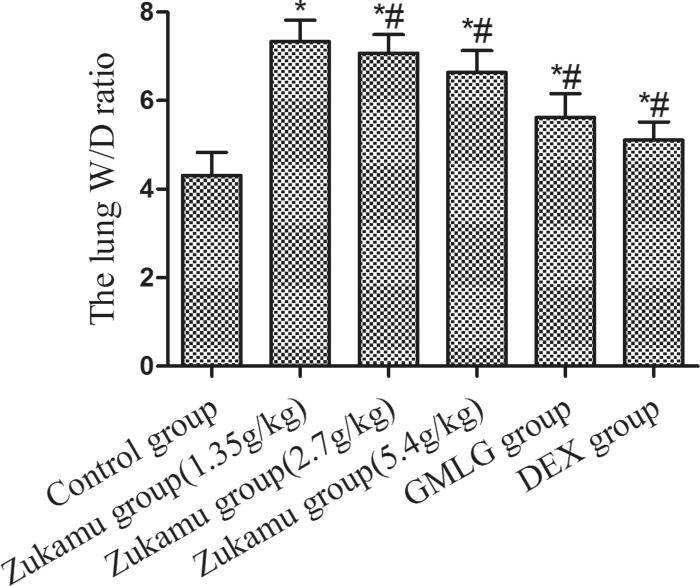
Zukamu decreased the lung W/D ratio of rats with acute lung injury. Sprague–Dawley rats were treated with different doses of zukamu (1.35, 2.7 and 5.4 g/kg) (ig.) and positive anti-inflammatory control drug DEX (ip.) Acute lung injury was induced by LPS injection 60 min after drug administration on the last day. The left lung tissues were collected, the wet and dry weights of the lungs were measured, and the lung W/D ratios were calculated. The data represent the mean ± SD, n = 10 per group. *p< 0.05 vs. control, #p< 0.05 vs. Model.